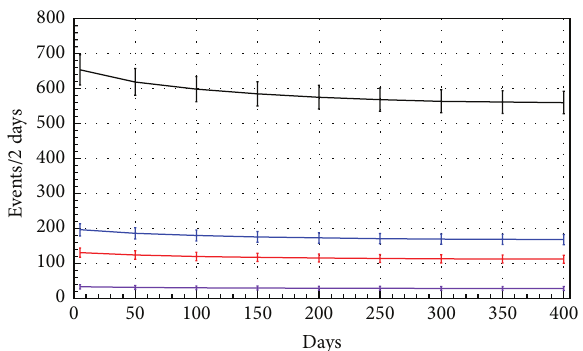
Figure 8: Number of events accumulated over 2 days of exposure along a complete cycle of 400 days at LVNPP with two reactors in 1ton of plastic scintillator. Curves for detection efficiencies (lower to higher) of 5%, 20%, 30%, and 100% are